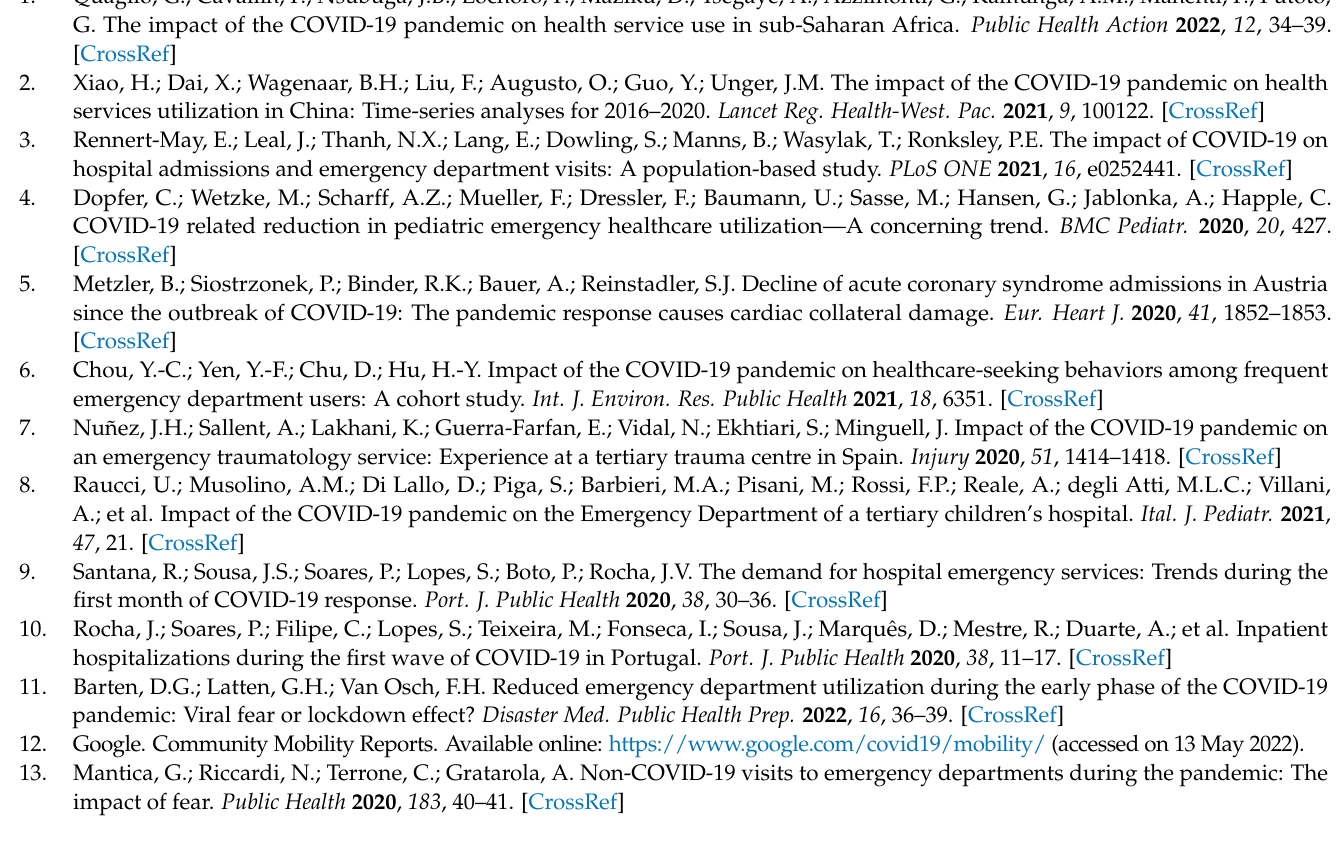
Figure S2: ED admissions in the North; Figure S3: ED admissions in LVT; Figure S4: ED admissions in the Centre; Figure S5: ED admissions in Algarve; Figure S6: ED admissions in Alentejo; Figure S7: Incidence rate of COVID-19 per 10 k inhabitants in mainland Portugal; Figure S8: Incidence rate of COVID-19 per 10 k inhabitants in the North; Figure S9: Incidence rate of COVID-19 per 10 k inhabitants in the Centre; Figure S10: Incidence rate of COVID-19 per 10 k inhabitants in LVT; Figure S11: Incidence rate of COVID-19 per 10 k inhabitants in Algarve; Figure S12: Incidence rate of COVID-19 per 10 k inhabitants in Alentejo; Figure S13: Vaccination coverage in mainland Portugal; Figure S14: Vaccination coverage in the North; Figure S15: Vaccination coverage in the Centre; Figure S16: Vaccination coverage in LVT; Figure S17: Vaccination coverage in Algarve; Figure S18: Vaccination coverage in Alentejo; Figure S19: Containment index in Portugal; Figure S20: Google search using the term “coronavirus” in Portugal; Figure S21: Mobility in